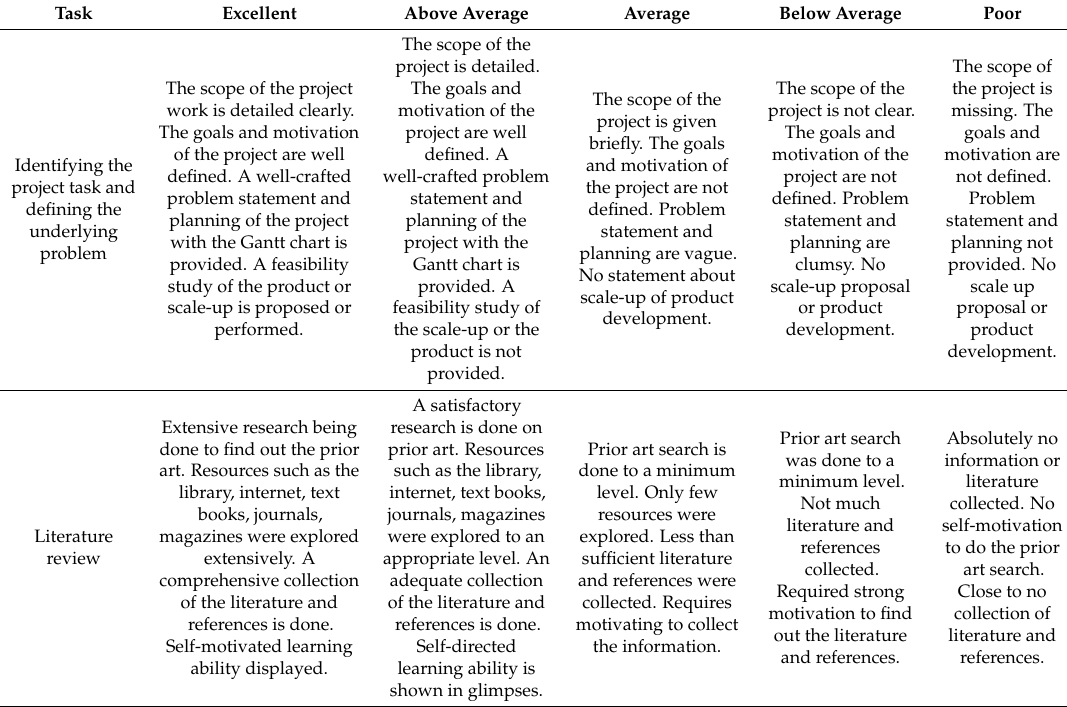
Table 7. Criteria for each